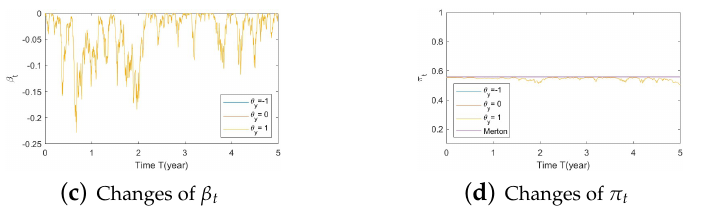
Figure A5. Illustrate the impact on ( a ) stock prices, ( b ) driver of elasticity, ( c ) elasticity of volatility, and ( d ) optimal stock allocations when varying θ y ( e . g ., θ y = − 1,0,1 ) .